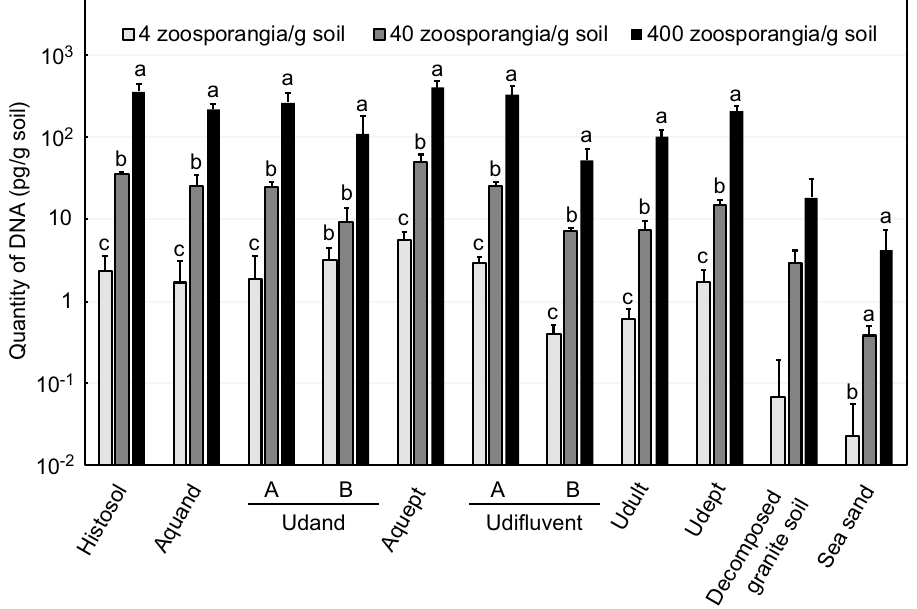
Figure 1. Quantities of P. infestans DNA determined using real-time PCR. No P. infestans DNA was detected in the negative control plots. Bars indicate the standard deviation. Means (n = 3) with different letters in the same soil type differed significantly according to post hoc tests ( p < 0.05, Tukey’s test, Games-Howell test or Steel– Dwass